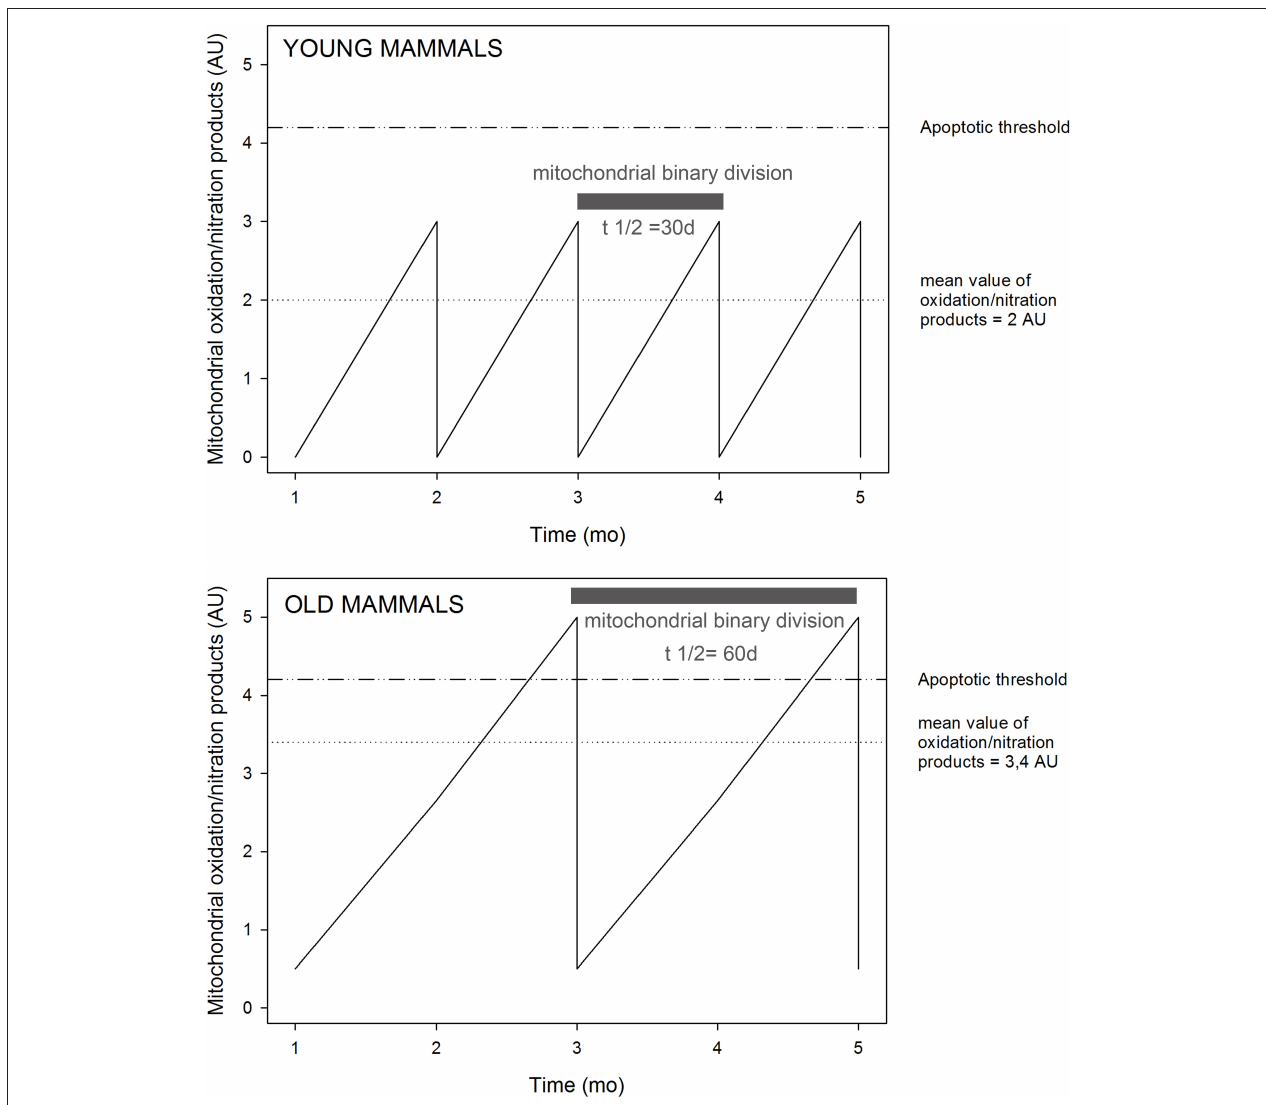
FIgurE 2 | Scheme illustrating the hypothesis of the time course of the levels of mitochondrial oxidation and nitration products, associated with mitochondrial turnover for brain mitochondria as a function of time and age. AU, arbitrary units. Modified from Navarro and Boveris